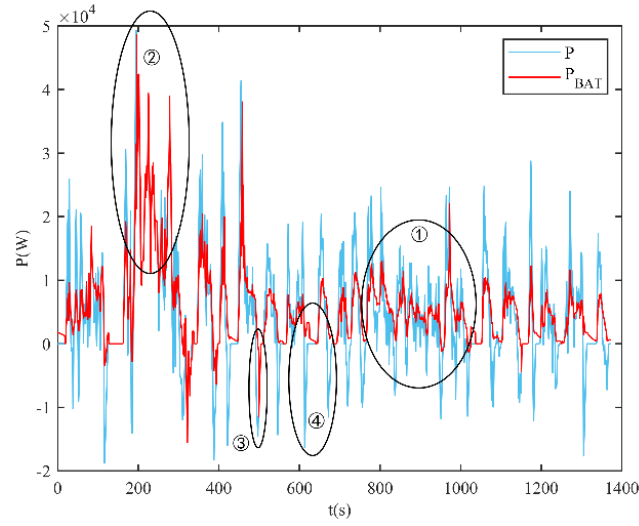
Figure 9. The curves of the battery output power and the total power demanded under UDDS.